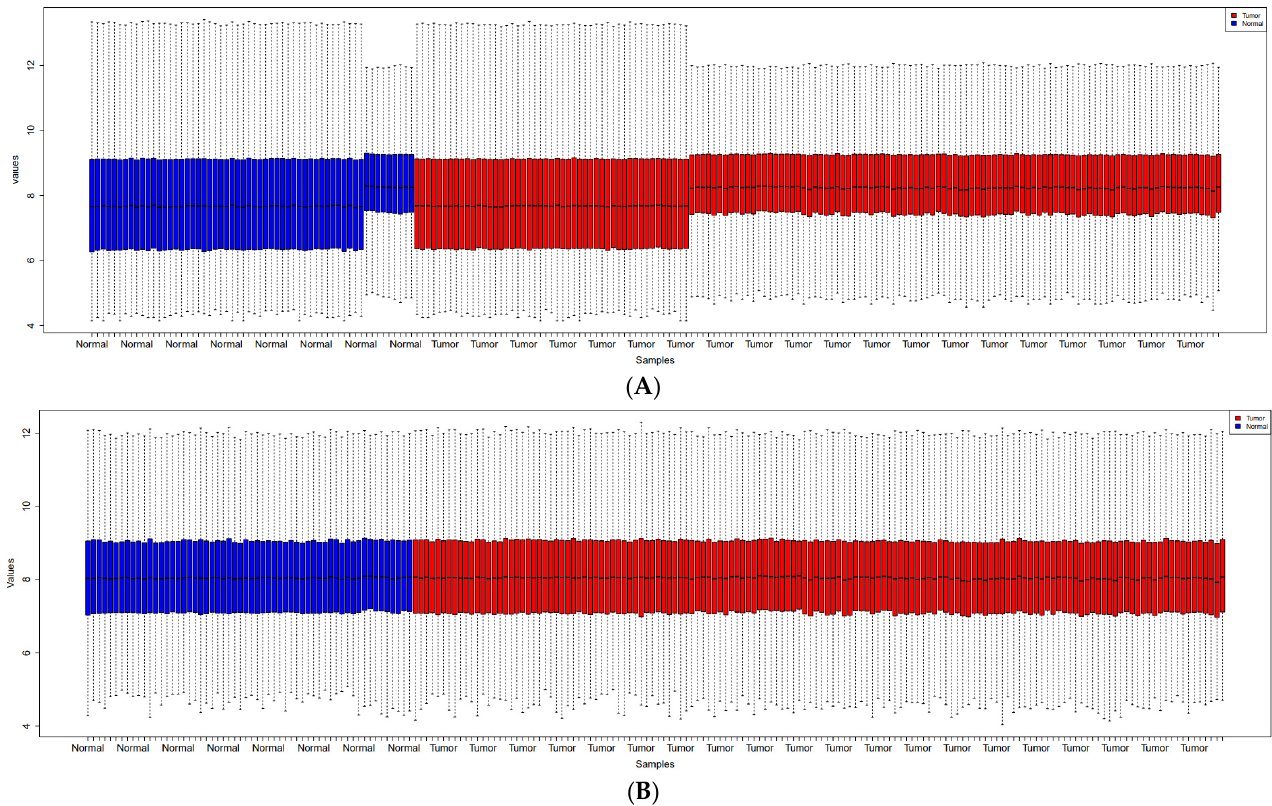
Figure 2. Boxplots show the raw data ( A ) and the normalized data following the removal of the batch effect ( B ). Prostate cancer samples are indicated by red boxes, whereas normal samples are shown by blue boxes.